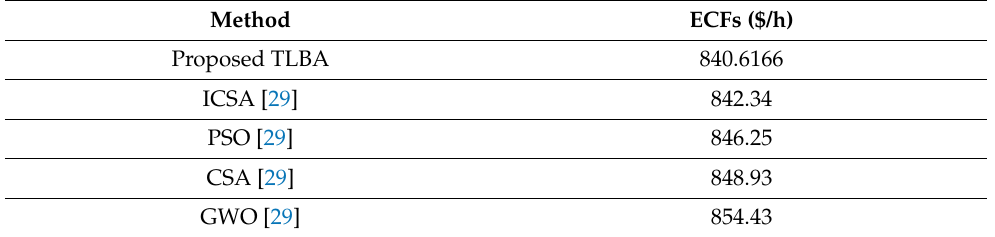
Table 2. Comparative results of the IEEE 30-bus network for the minimization of the TFCs.